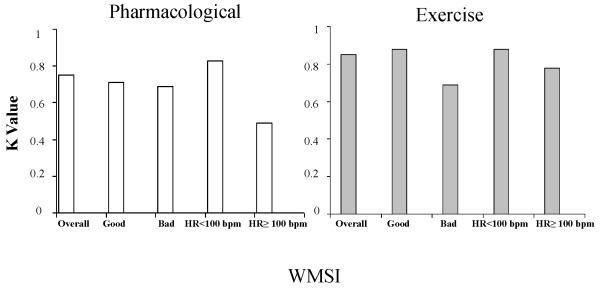
Agreement between two different observers for the evaluation of RT3D WMSI considering two different groups: exercise and pharmacological stress echo. In the graph the K value according to image quality and heart rate at peak stress is reported.